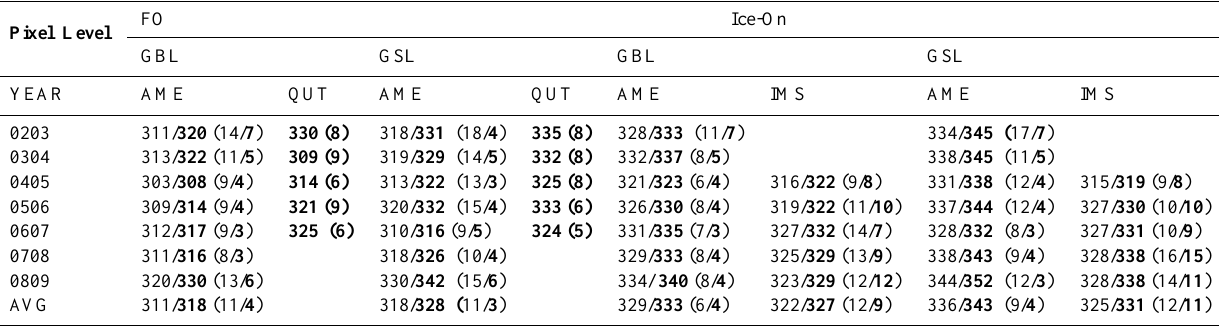
Table 6. Comparison of ice phenology variables for freeze-up period (FO and Ice-On) daily-derived from AMSR-E (AME), QuikSCAT (QUT) and NOAA/IMS (IMS) products for GBL and GSL (2002–2009). Values within confidence regions in bold. Standard deviation in parentheses.